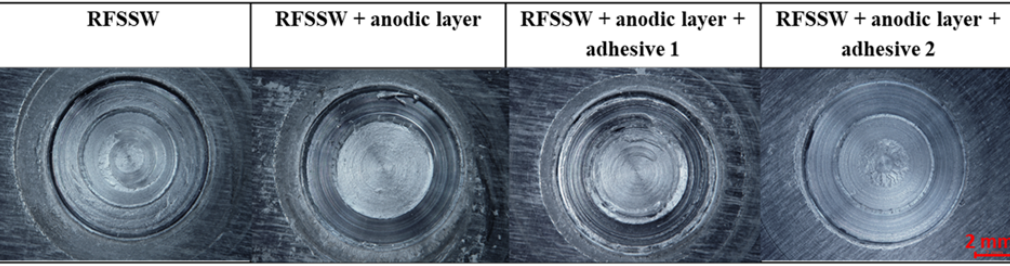
Figure 4. RFSSW weld face of examined samples .